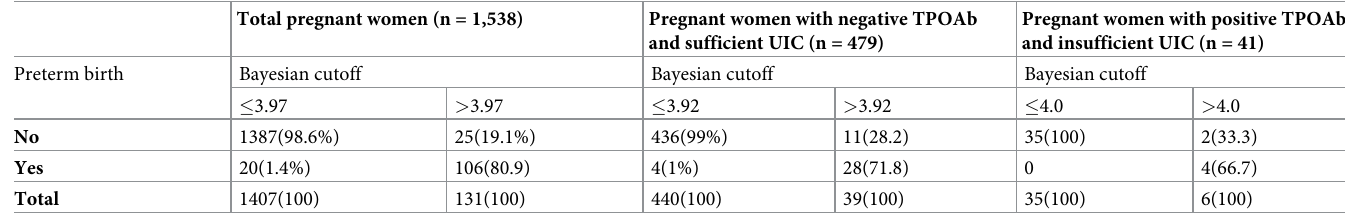
Table 3. Frequency of participants with and without preterm birth by TSH level dichotomized by Bayesian estimated optimal cutoff, for all participants, and each subpopulation. Total pregnant women (n = 1,538) Pregnant women with negative TPOAb Pregnant women with positive TPOAb and sufficient UIC (n = 479) and insufficient UIC (n = 41) Preterm birth Bayesian cutoff Bayesian cutoff Bayesian